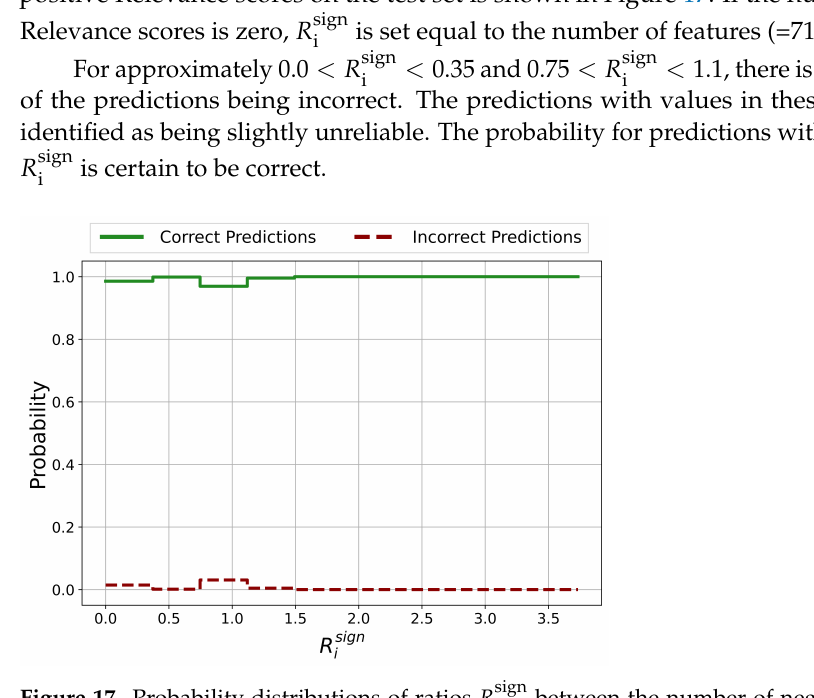
Figure 17. Probability distributions of ratios R sign between the number of negative and positive i Relevance scores for correct (green solid line) and incorrect (red dashed line). The predictions with < 0.35 and 0.75 < R sign < 1.1 can be identified as being slightly unreliable. 0.0 < R sign i i